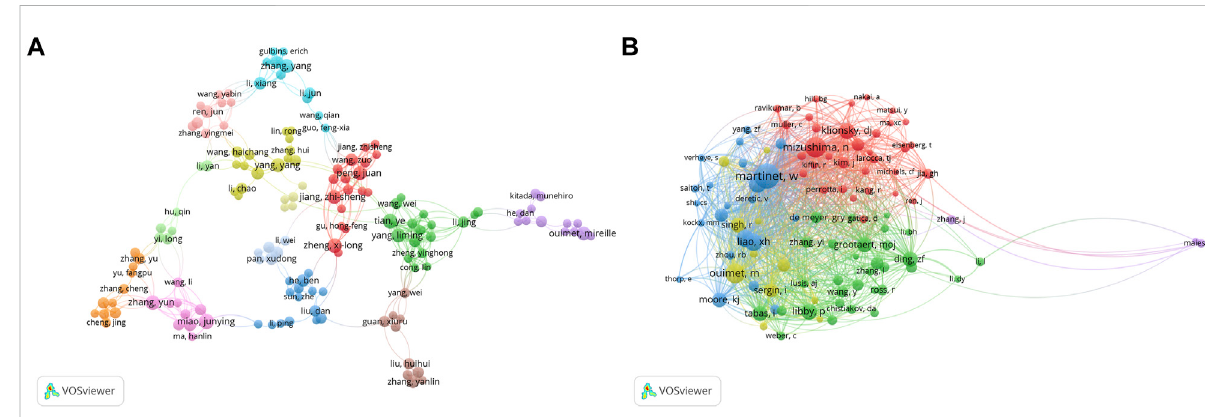
FIGURE 3 Analysis of author and cited author. (A) Author co-authorship network analysis based on VOSviewer visualization map; (B) Author co-citation network analysis based on VOSviewer visualization map. Different color clustering re fl ects the cooperative relationship between